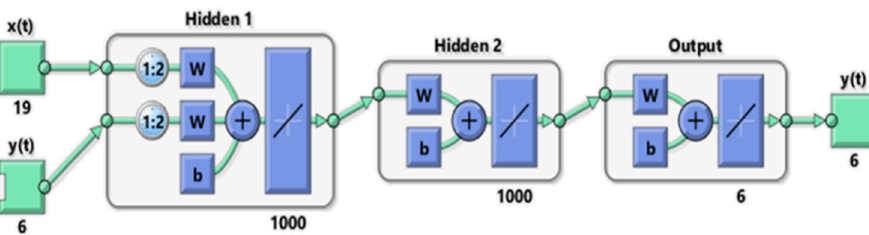
Figure 9. NARX Neural Network topology.